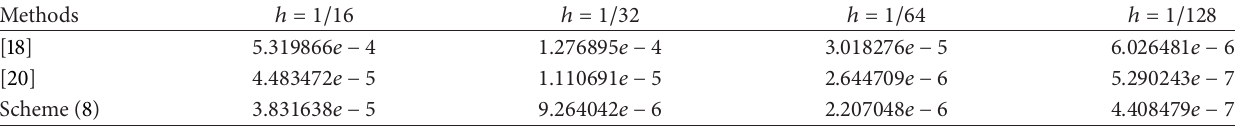
Table 1: The maximal errors of numerical solutions at 𝑡 = 10 , 𝜏 = 0.1 , 𝛽 = 1 , 𝛼 = 2 , and 𝑝 = 2 .